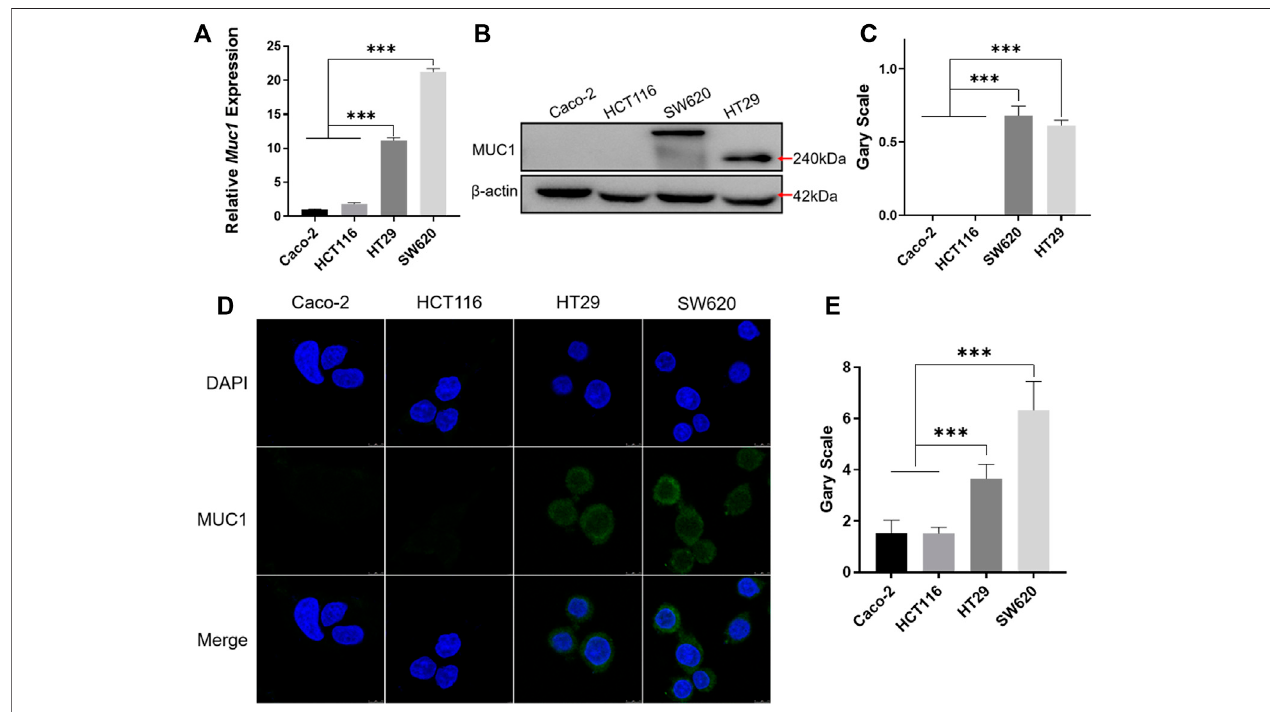
FIGURE4| Identi fi cation ofMUC1 expression incolorectalcancercells. (A) Real-time quantitativePCRanalysisofMUC1 expression at themRNAlevel inCaco-2, HCT116, HT29, and SW620 cell lines. (B) Western blot analysis of MUC1 expression in four cell lines. (C) Quantitative histogram of Western blot results. (D) Cellular immuno fl uorescence assay for the identi fi cation of MUC1 expression in four cell lines. (E) Quantitative histogram of cellular immuno fl uorescence results. ***p < 0.001.